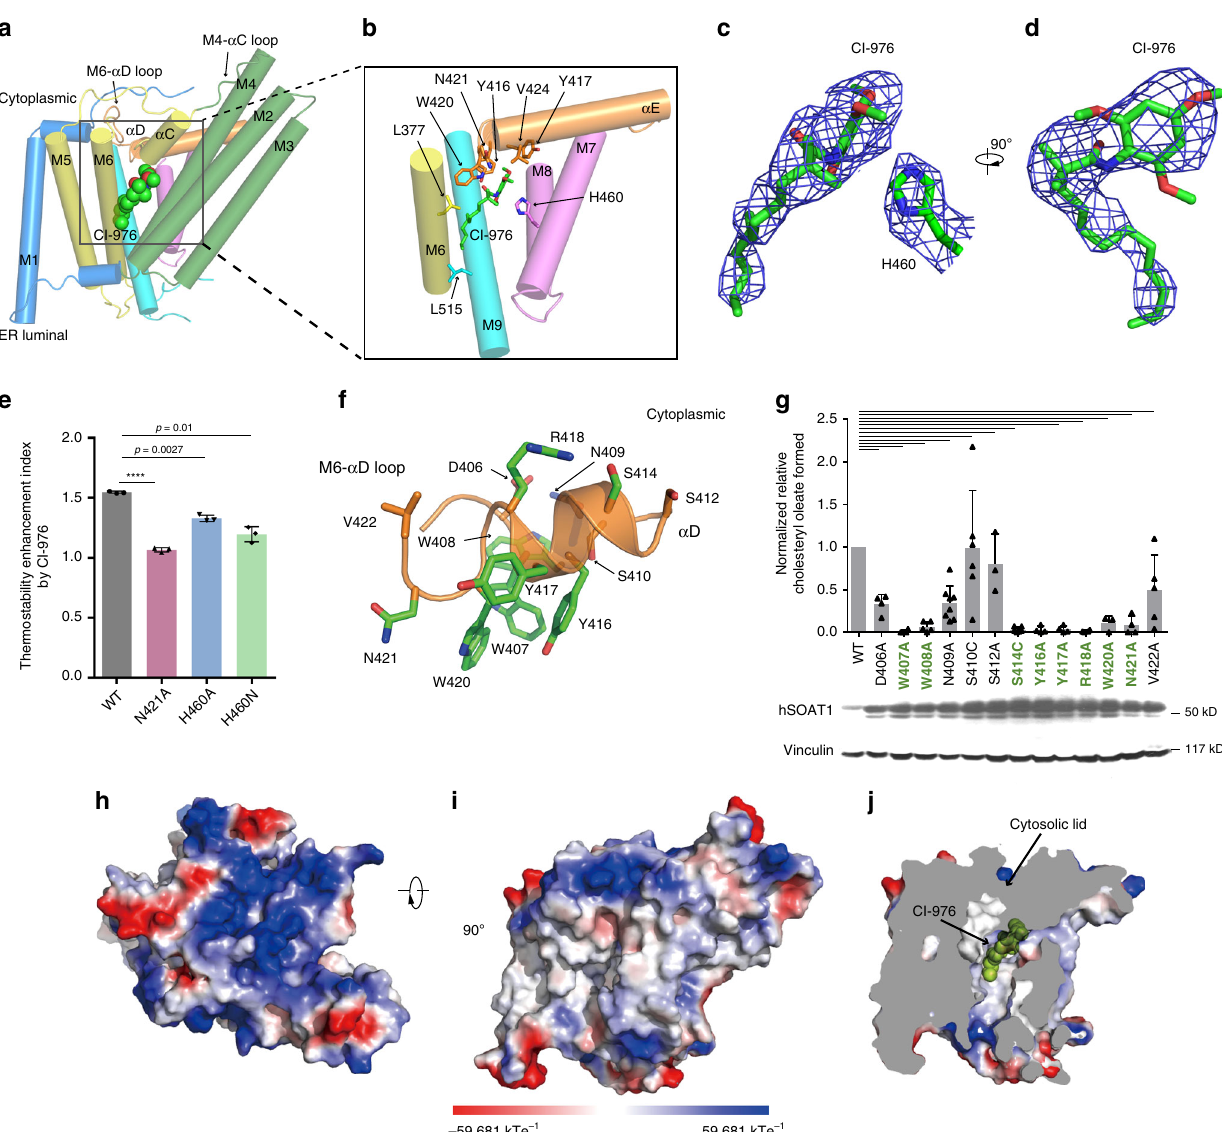
Fig. 5 The catalytic chamber and the CI-976 binding site in hSOAT1. a Side views of one hSOAT1 subunit in cartoon representation. The transmembrane helices are colored in the same way as in Fig. 3c, d. The inhibitor CI-976 is shown in lemon sphere. b Close-up view of CI-976 binding sites. Residues that interact with CI-976 are shown as sticks. c Electron density of CI-976 and catalytic H460 were shown in blue meshes at the same contour level. Maps were further sharpened at − 50 Å2 by Coot for visualization. d A 90° rotated view of c, density of H460 was omitted. e The thermostability enhancement effect of CI-976 on various hSOAT1 dimer mutants. The thermostability enhancement index was calculated by dividing dimer/monomer peak height ratio in the presence of CI-976 with the peak height ratio in the presence of DMSO alone (Data are shown as means± standard deviations, n = 3 biologically independent samples, **** p < 0.0001 for N421A; p = 0.0027 for H460A; p = 0.0100 for H460N respectively, two-tailed paired t -tests). f Close-up view of the M6- α D loop and α D with side chains shown in sticks. Residues that are important for SOAT1 enzyme activity reported in g were colored in green. g Enzymatic activities of various hSOAT1 mutants. (For D406A, n = 4. For W407A, n = 4. For W408A, n = 5. For N409A, n = 8. For S410C, n = 6. For S412A, n = 3. For S414C, n = 6. For Y416A, n = 4. For Y417A, n = 4. For R418A, n = 4. For W420A, n = 3. For N421A, n = 4. For V422A, n = 5 biologically independent samples.) Data are shown as means ± standard errors. A two-tailed unpaired t test was used to calculate the p values. For S410C, p = 0.9434. For S412A, p = 0.017. Other mutants had p values less than 0.0001. The expression levels of hSOAT1 mutants and endogenous vinculin are shown below. The original blots were provided as a Source Data fi le. h , i The top and side views of one hSOAT1 monomer in the surface representation. The surfaces are colored by electrostatic potential calculated by Pymol. j The cut-away view showing the binding pocket of the inhibitor CI-976 inside the reaction chamber. Source data are provided as a Source Data fi